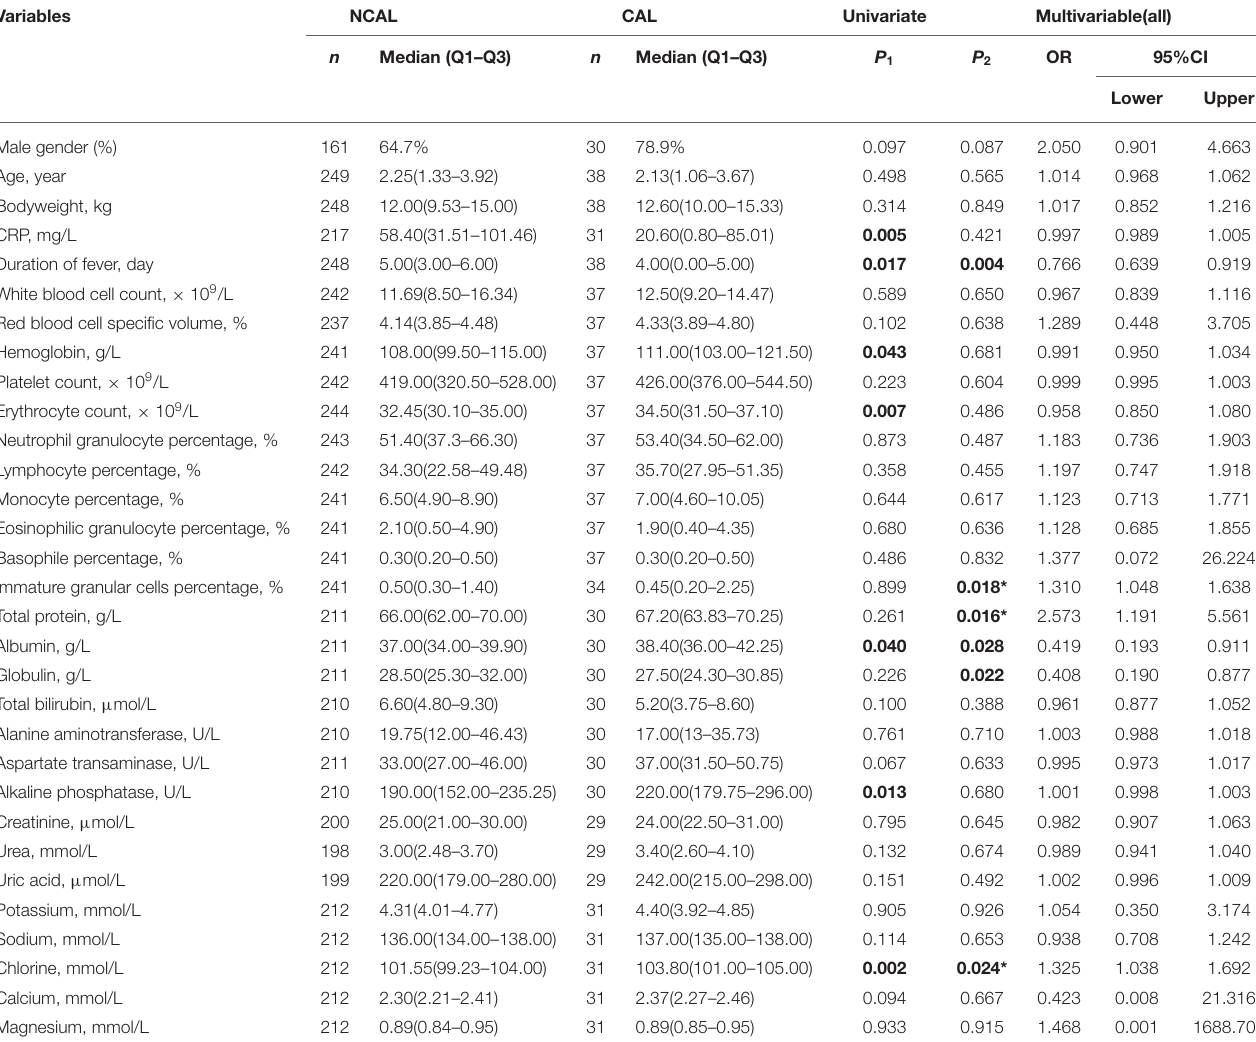
TABLE 1 | Comparison of groups with and without coronary artery